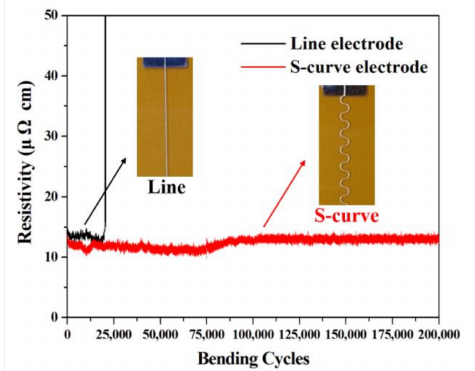
Figure 8. Bending durability results of the S-shaped electrode at a curing temperature of 170 ◦